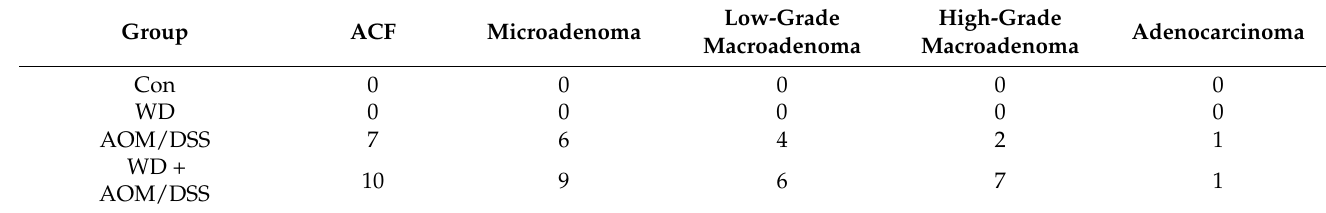
Table 6. Tumorigenicity